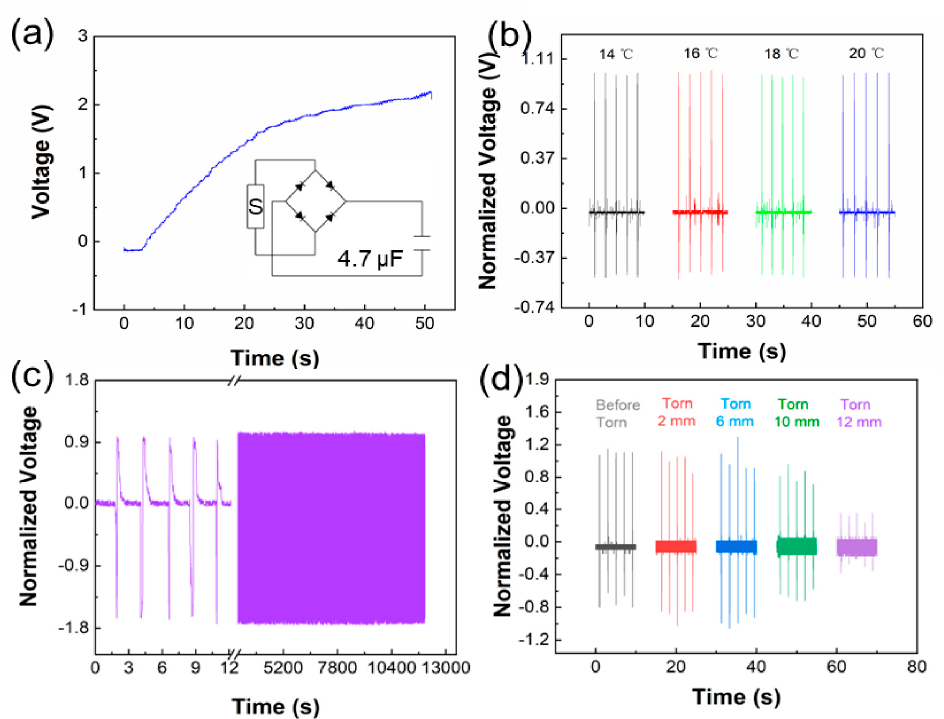
Figure 4. ( a ) Charging a 4.7 μ f capacitor through a rectifying bridge; ( b ) output piezoelectric volt- age of sensor at different temperatures; ( c ) durability of the sensor for 3.5 h; ( d ) the output piezoelectric voltage after cutting the sensor.